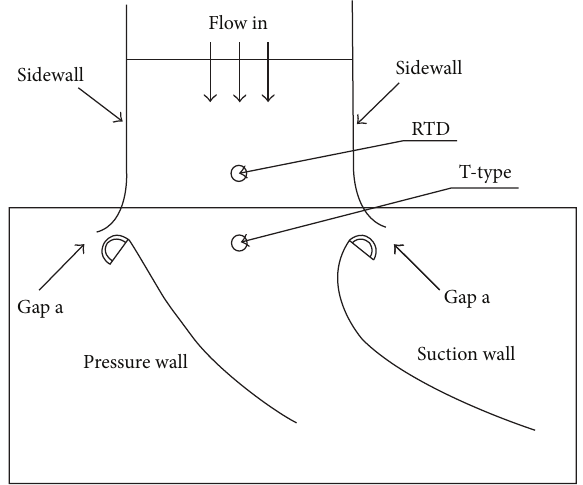
Figure 2: The test section with two side gaps and temperature measurement